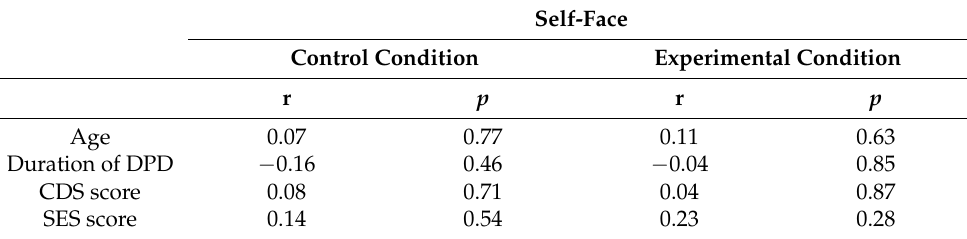
Table 3. Results of the correlational analysis between subliminal self-face processing and other variables in patients with